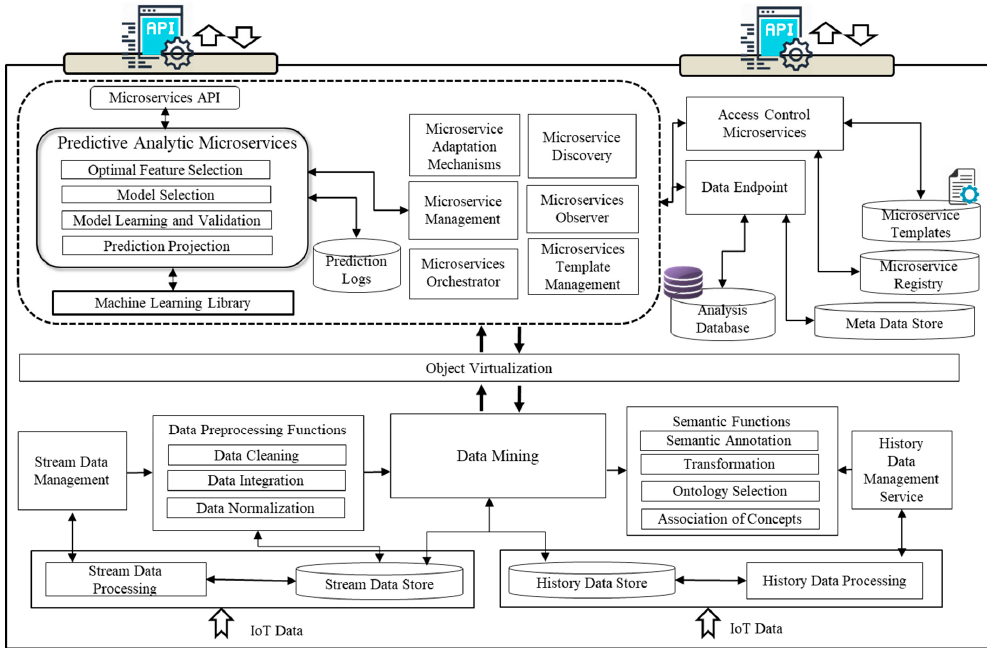
Figure 1. Design of microservices to support predictive analytics.